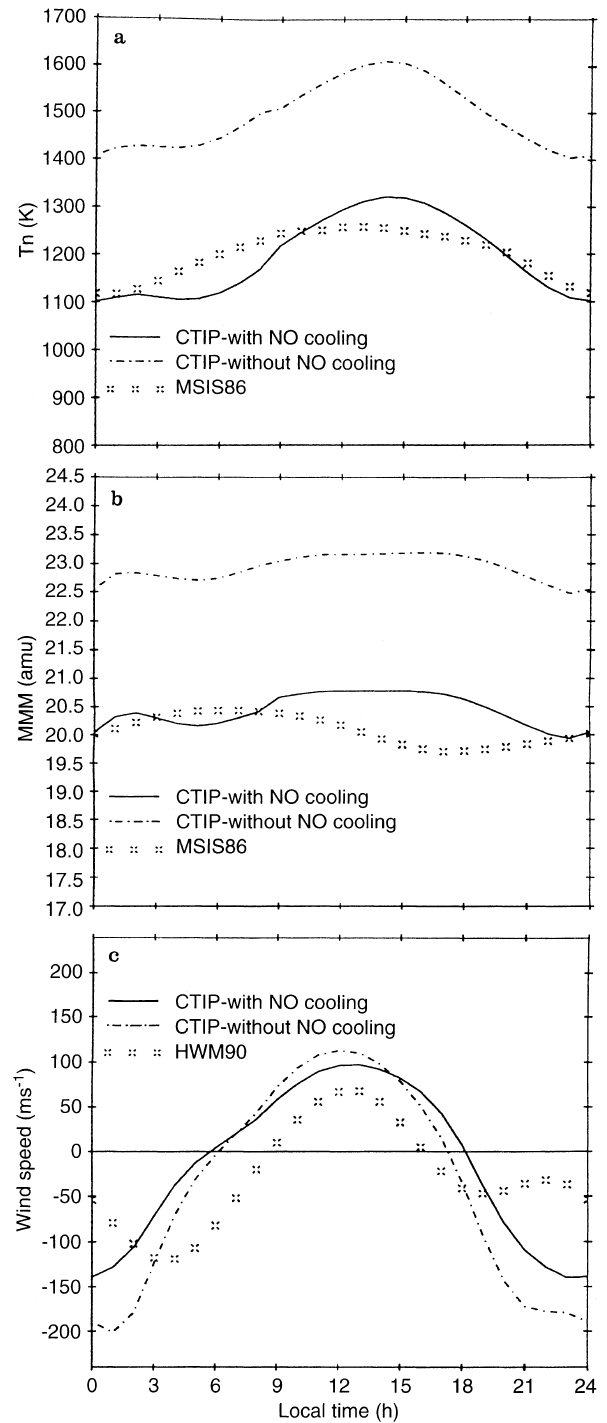
Fig. 6a–c. The effect of NO cooling on the neutral parameters a T n ; b mmm and c V x (positive polewards) at 300 km over Argentine Islands (with new heating rate and photodissociation already included